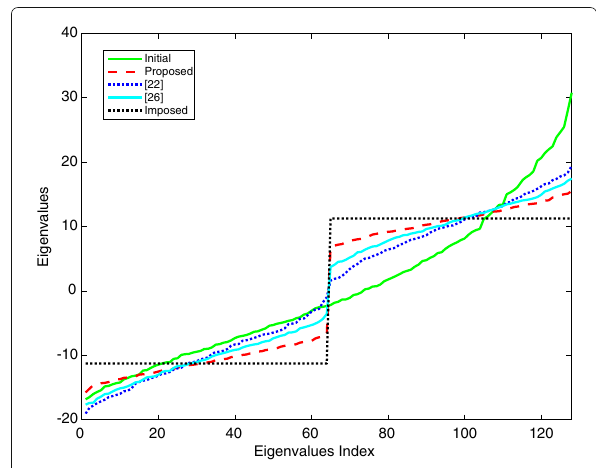
Fig. 4 The spectrum of the signature matrix of a 64 × 128 random Gaussian matrix, a frame obtained with the proposed Algorithm 4, and frames obtained with [22], [26]. The black dotted line stands for the spectrum of the signature matrix corresponding to a 64 × 128 ETF